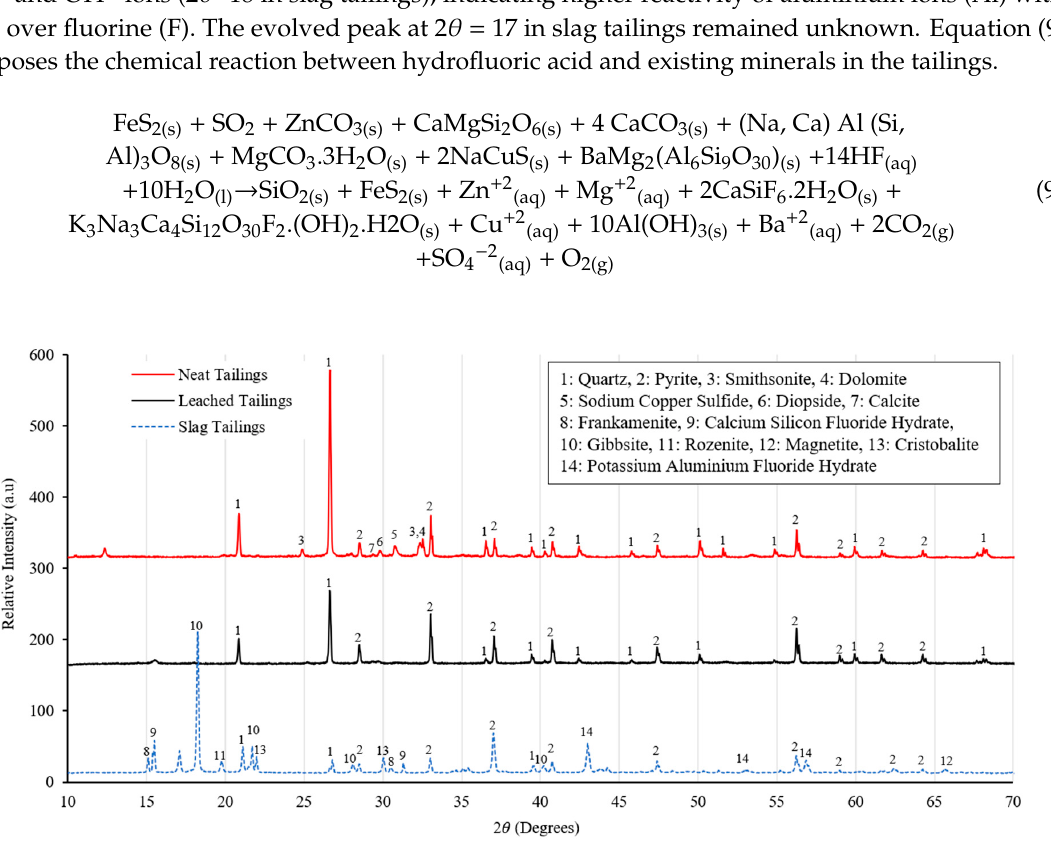
Figure 1. XRD results of hydrofluoric acid leaching on tailings.